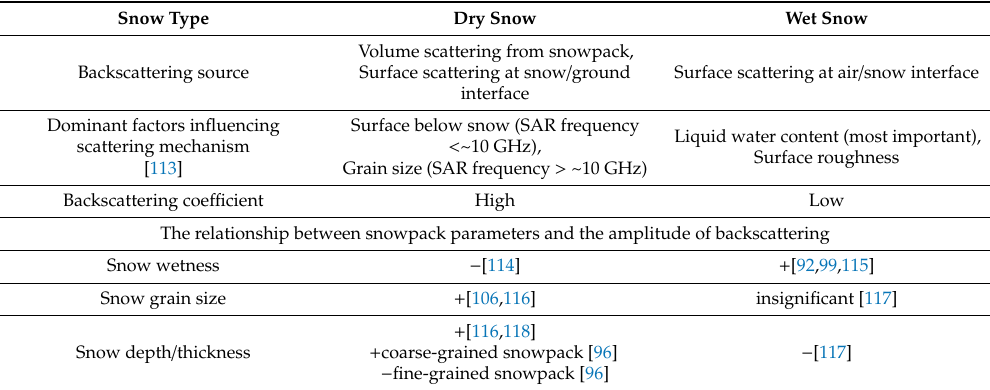
Table 2. E ff ects of wet and dry snow on the SAR signal based on the snow physiology. “ + ” refers to positive correlation, “ − ” to negative correlation. The number in brackets refers to the reference